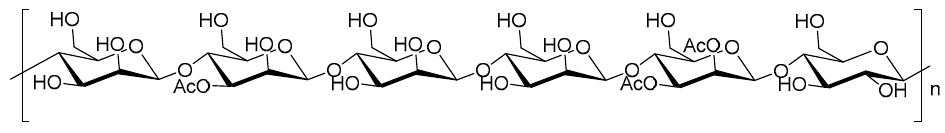
Figure 1. The structure of O -acetylated glucomannan according to published papers [22,24,25].